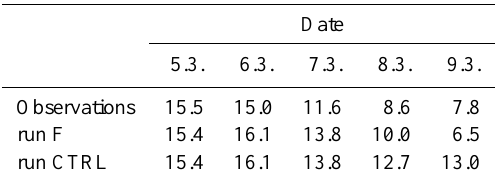
Table 5. Observed and simulated daily temperature range (DTR) in K for